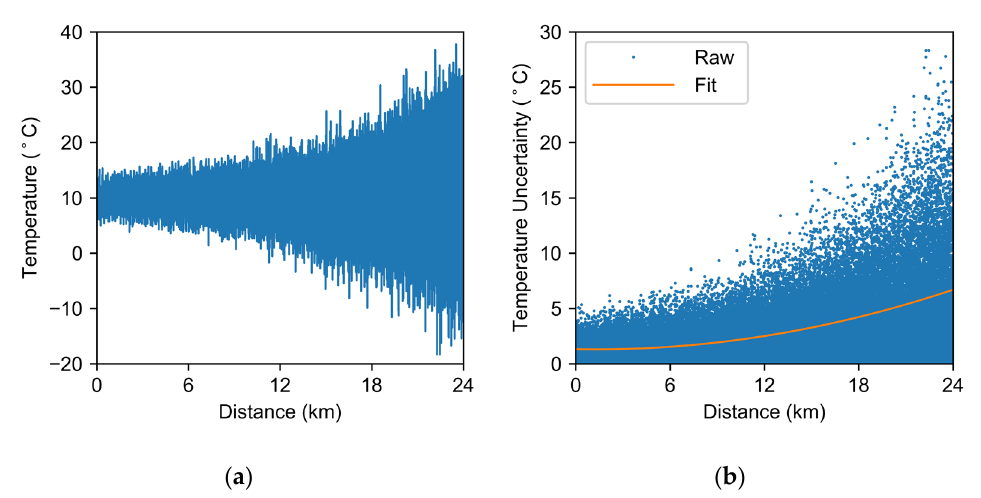
Figure 3. ( a ) Temperature profile measured with raw data at room temperature. ( b ) Temperature uncertainty distribution. uncertainty